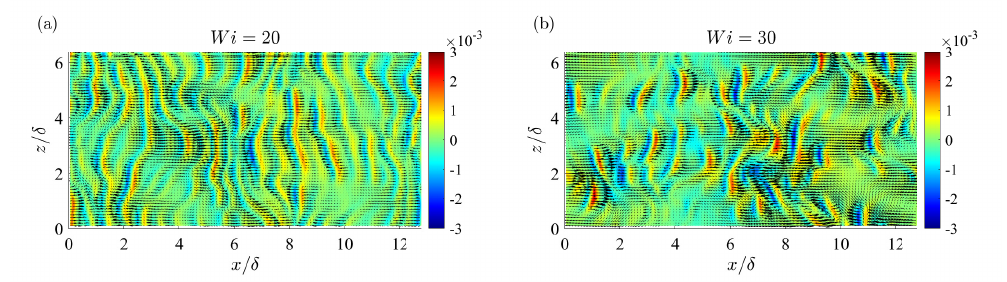
Figure 7. Snapshots of elongated spanwise-oriented structures in the x – z plane at the channel center for Re = 10 and ( a ) Wi = 20 and ( b ) Wi = 30. Color contours and vectors show v (cid:48) and in-plane velocity components ( u (cid:48) , w (cid:48) ), respectively.